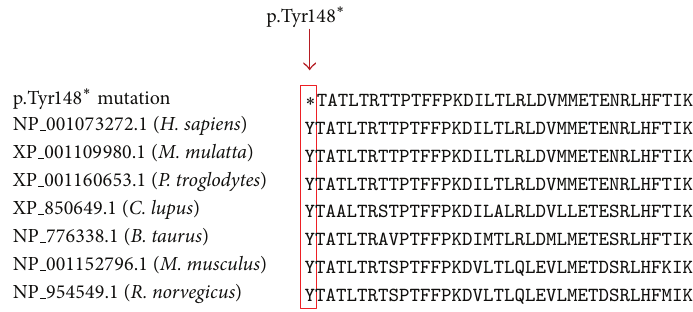
Figure 4: Multiple sequence alignments of GAA homologous sequences in different species are shown. Nonsense mutation reported in this study is highlighted by a red rectangle, illustrating that the p.Tyr14 8 ∗ mutation is in a highly conserved region.